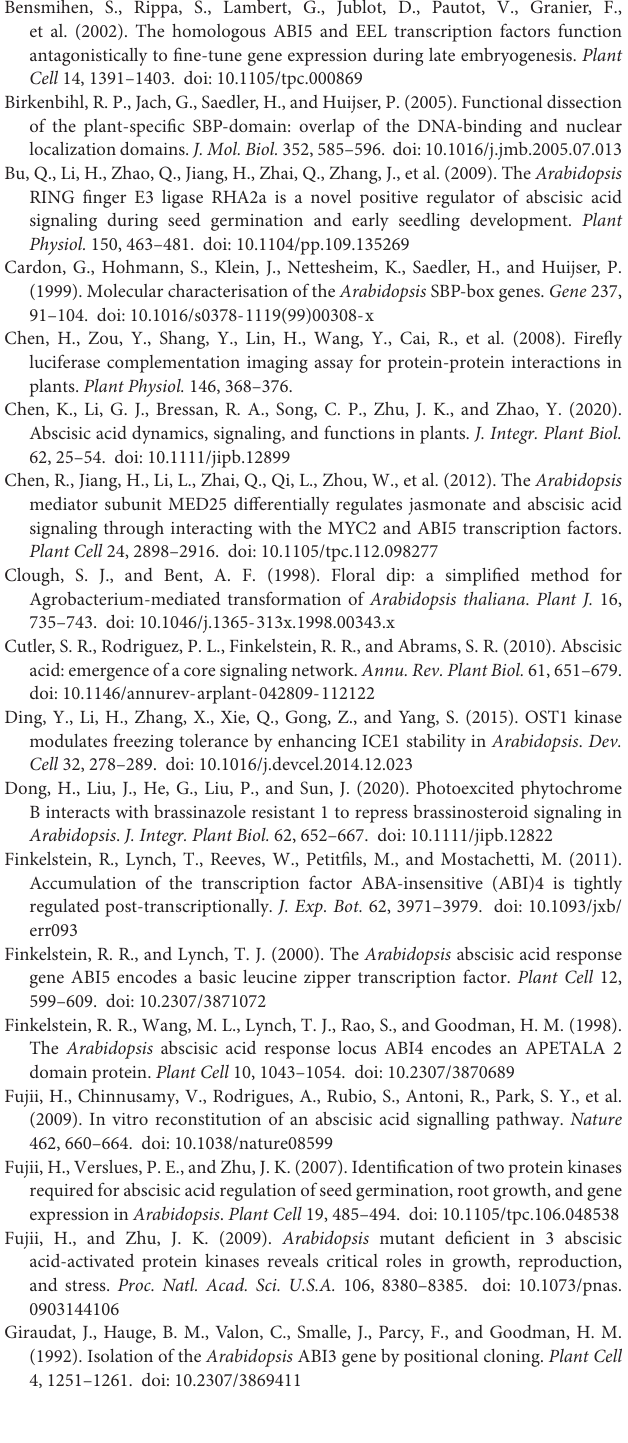
Supplementary Table 1 | Primers used for DNA constructs in this study. Supplementary Table 2 | Constructs used in this study.